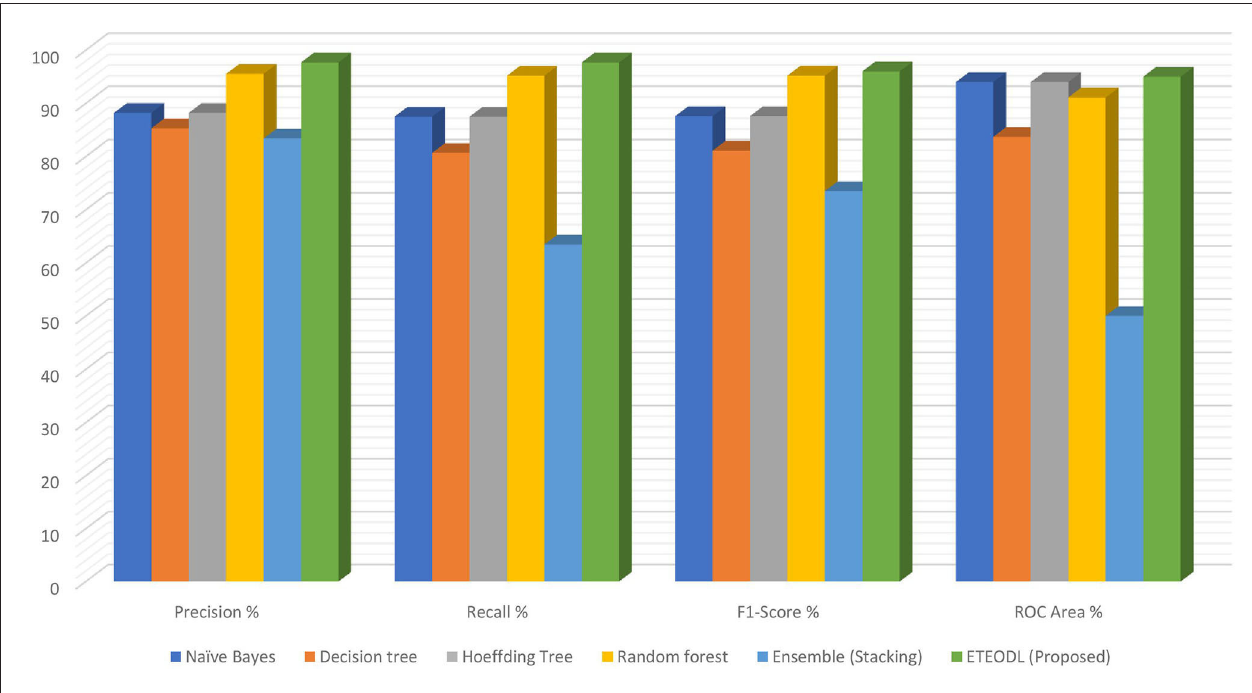
FIGURE 4 | Comparison of precision, recall, F1-score, and ROC